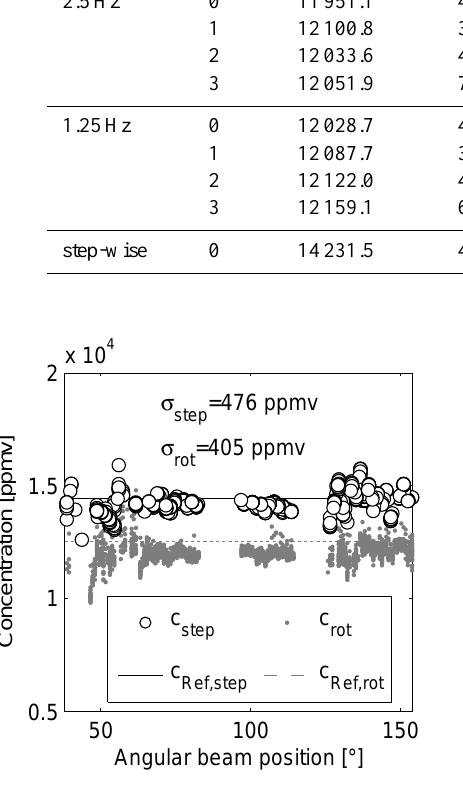
Figure 5. H 2 O-measurement with step-wise scanned laser beam ( c step ) compared to the measurement with continuously moved laser beam ( c rot , field rate 1.25Hz). The lines depict the average reference H 2 O-concentrations,